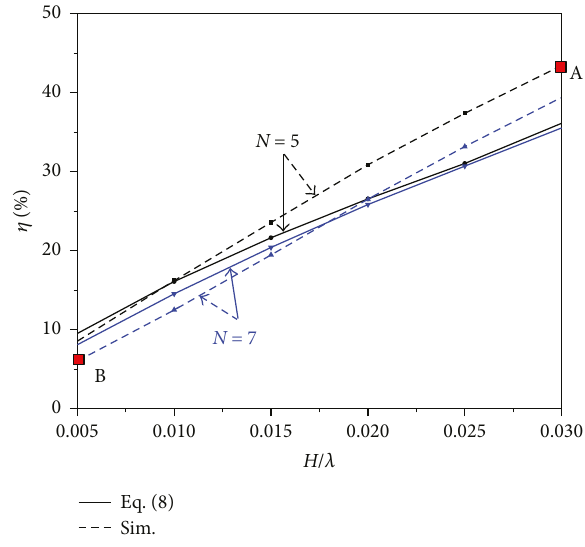
Figure 6: Comparison of NMHA e ffi ciency.